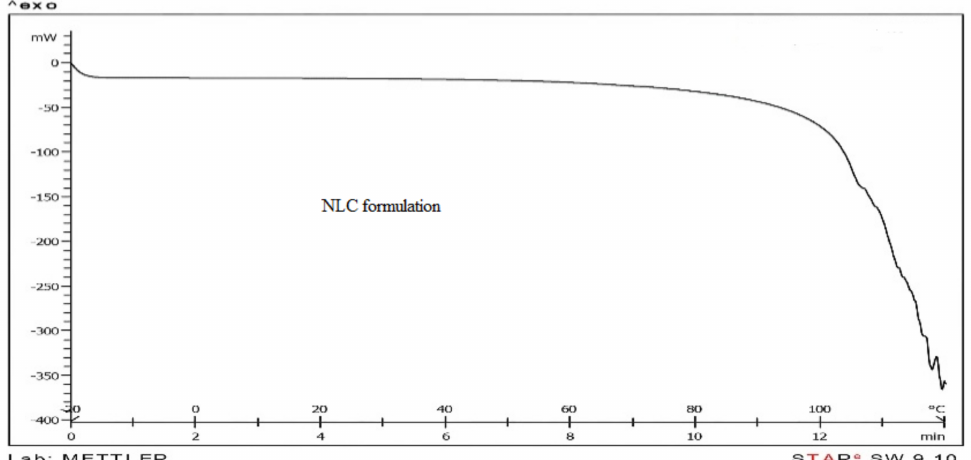
Figure 4. Thermograms: ( Top ) cornea in buffer solution; ( Middle ) cornea in contact with NLC formulation; ( Bottom ) NLC